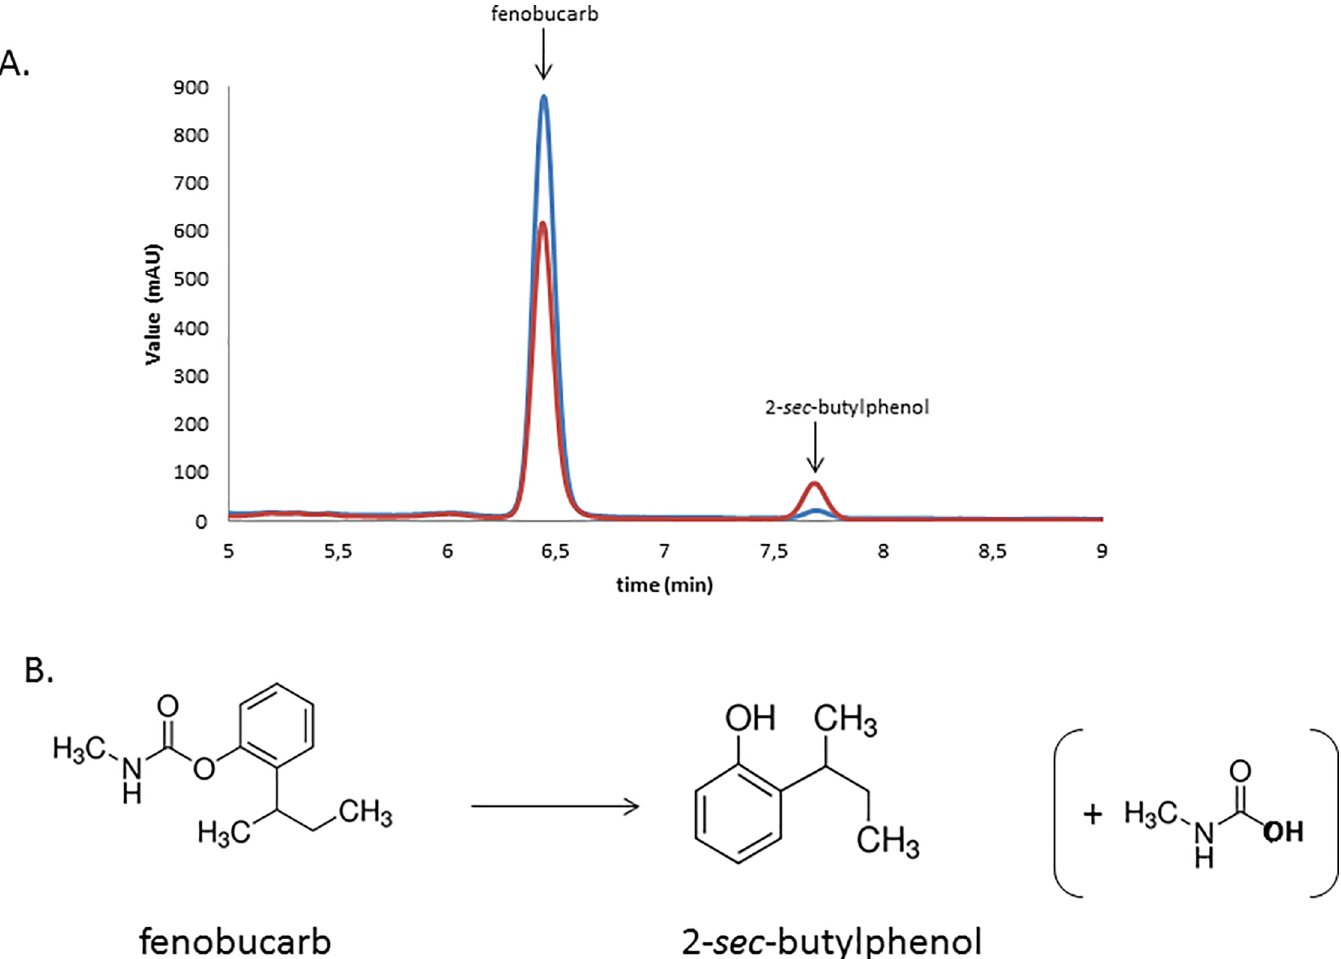
Fig 3. A. HPLC analysisfrom the reactionof fenobucarb with 44I12 enzymatic extract at the beginning of the reaction (blue) and after 24 h of reaction(red). B. Convertionof fenobucarb to 2–sec-butylphenol.